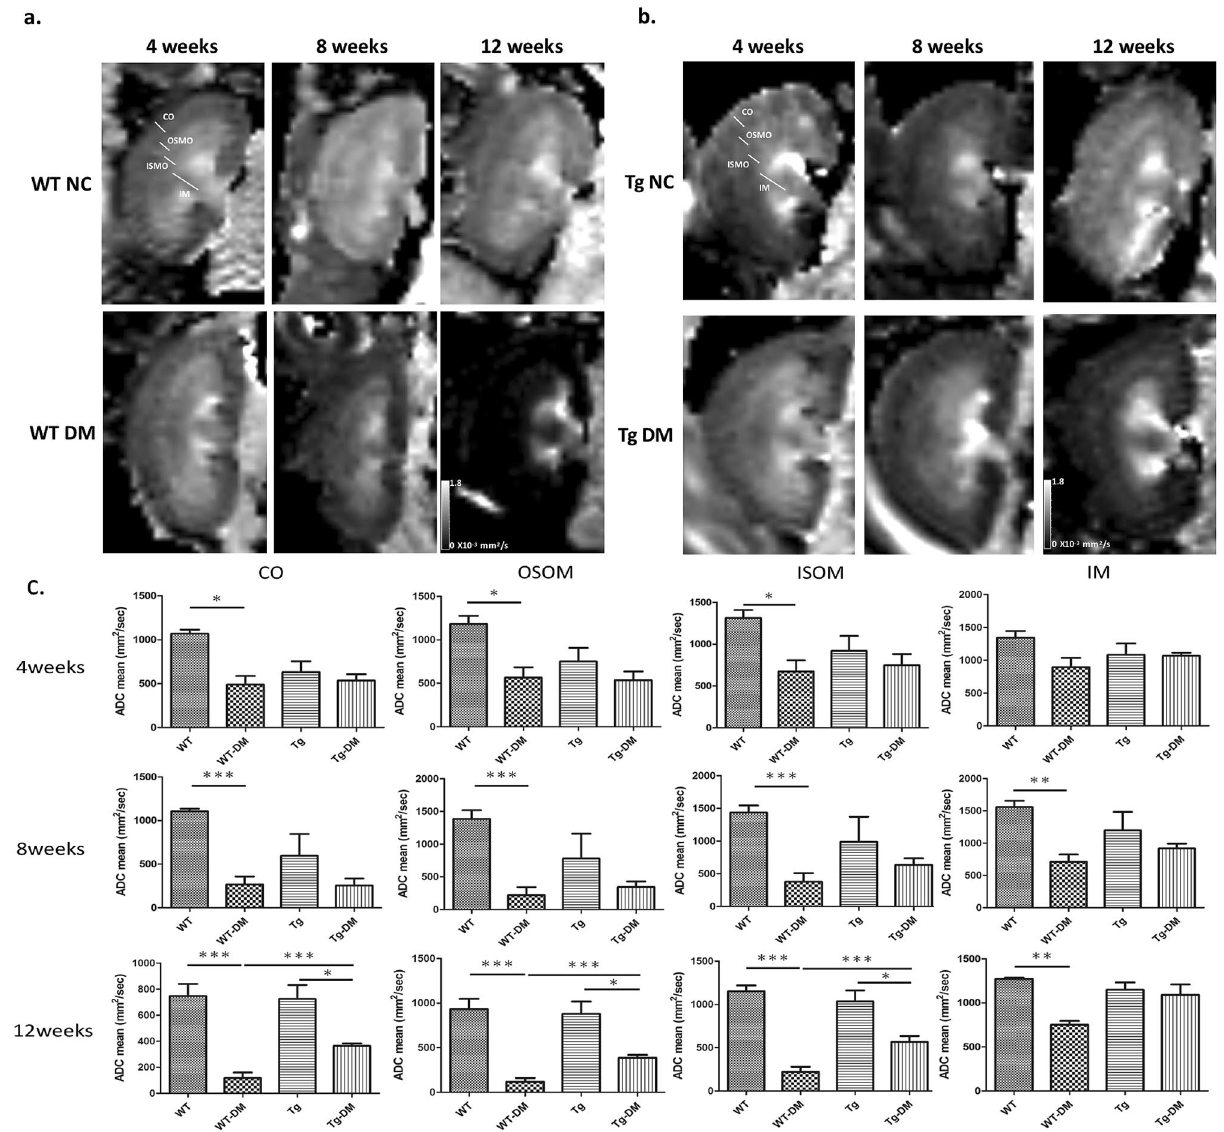
Figure 4. Apparent diffusion coefficient (ADC) mapping of kidneys in control and DM groups. (a) WT control and DM; (b) miR29a Tg control and DM. ADC mapping was decreased during STZ-induced DM model. ROIs were copied from b0 images to ADC mapping, and ADC values were calculated separately for all anatomic layers at different times (c) . (* < 0.05, ** < 0.01, and *** < 0.001 with one-way ANOVA analysis, significant difference between